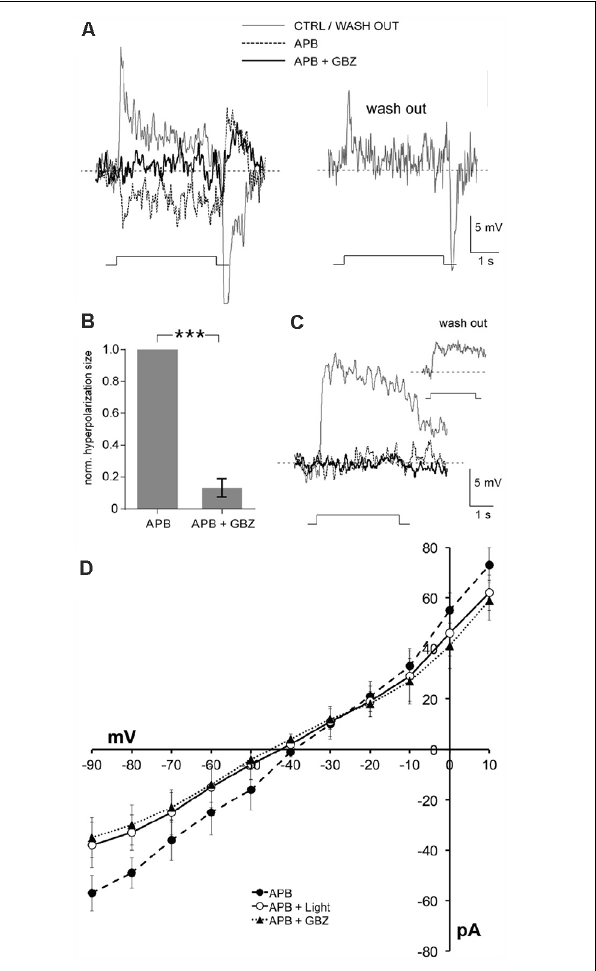
FIGURE 5 | Hyperpolarizing surround light responses of ON-cBCs are produced by a reduction in tonic endogenous GABA A R excitation.In the presence of dopamine (5 µ M) and the glutamate analog APB (i.e., L-AP4; 50 µ M), a selective agonist of the mGluR6-Rs on both ON-cBC and rod BC dendrites that blocks cone to ON-cBC and rod to rod BC signaling (Slaughter and Miller, 1981), ON-cBCs ( A,B ), but not rod BCs (C) , produced hyperpolarizing surround responses to large (500- µ m wide) centered bar stimuli that were blocked by gabazine (GBZ; 50 µ M; 9 out of 9 cells). Washout of APB and GBZ showed recovery from their effects (A–C) . (B) For each ON-cBC, addition of GBZ to the APB-containing medium greatly reduced the average normalized size of hyperpolarizing surround light responses (*** p < 0.001; paired t-test ; n = 9). (D) Comparison of the current-voltage relationship of ON-cBCs ( n = 5) following applications of APB alone in the dark and during surround light responses, and following application of both APB and GBZ in the dark. Average steady-state current at each holding potential (i.e., current measured near the end of the voltage pulses and when the amplitude of the light responses was relatively steady) is shown for all three experimental conditions. Modified from Chaffiol et al. (2017).